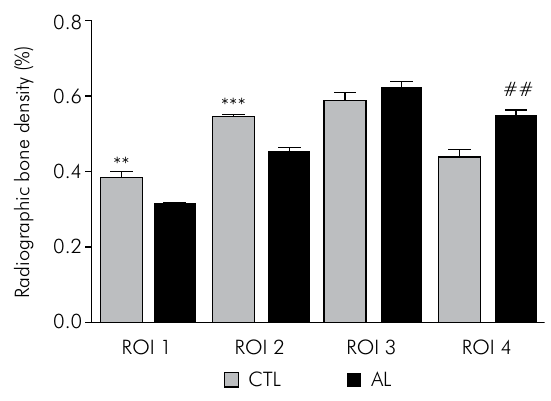
Figure 5. Percentage of radiographic bone density (%) in experimental groups 28 days after tooth extractions. ROIs 1 and 2 of CTL animals exhibited a statistically significant increase in radiographic bone density compared with ROIs 1 and 2 of animals treated with ALN (**p < 0.01 in relation to ROI 1 of AL; ***p < 0.001 in relation to ROI 2 of AL). Furthermore, ROI 4 of ALN-treated animals exhibited a statistically significant increase in radiographic bone density compared with ROI 4 of matched controls (##p < 0.01 in relation to ROI 4 of AL).